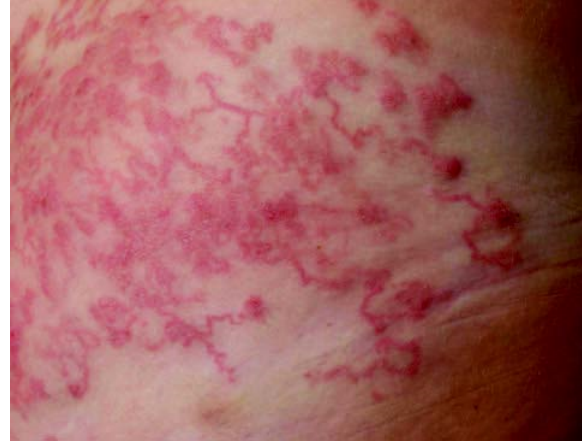
Figure 2: Infestation with several nematodes and the accompanying inflammatory reaction Diagnosis/differential